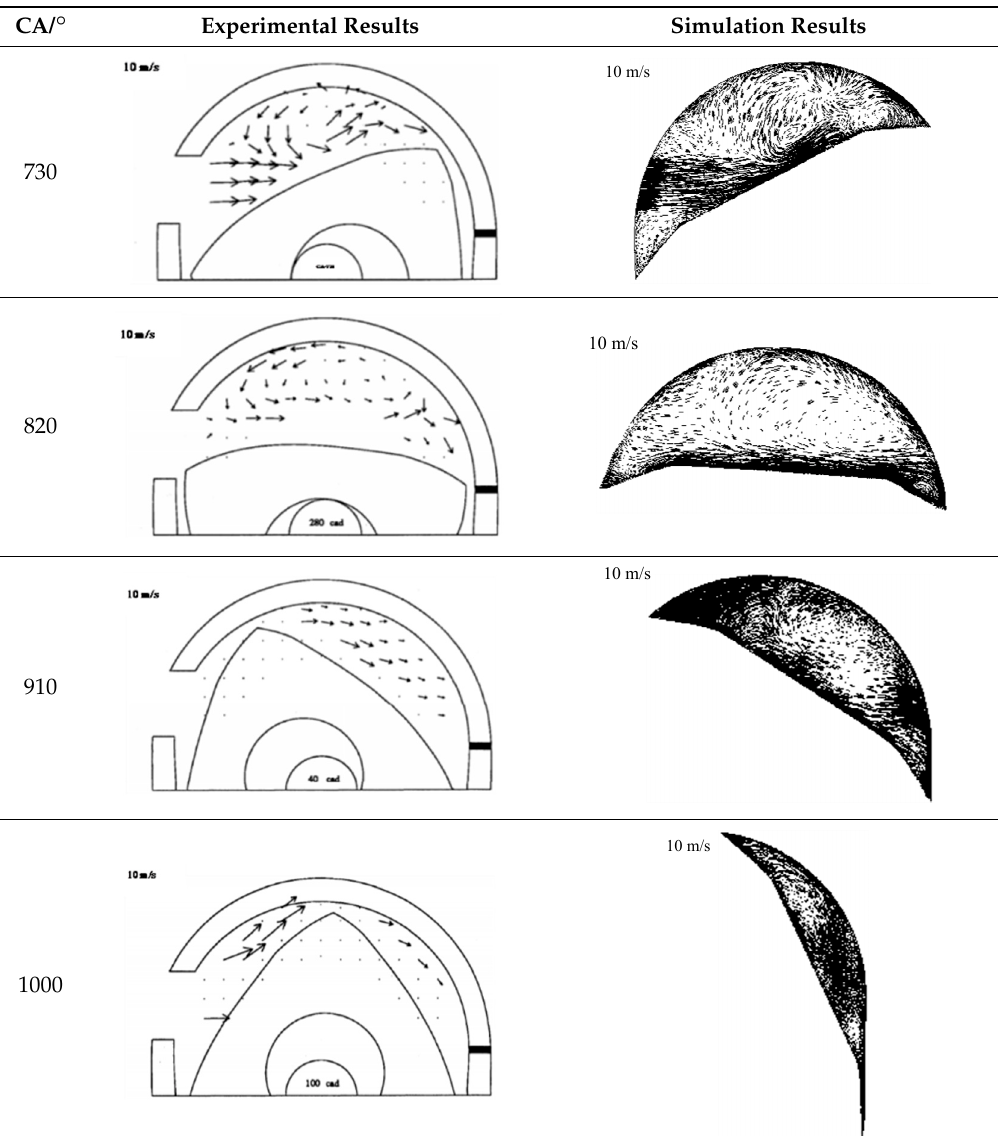
Table 2. Comparison of the experimental data with the simulation results.